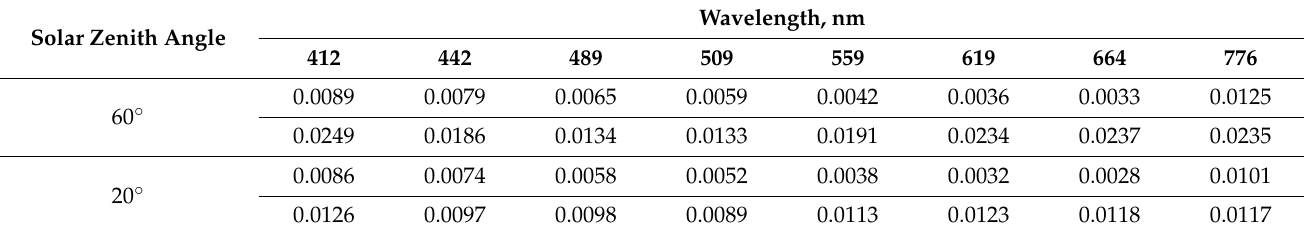
Table 6. RMSE of reflectance retrieval for dark (upper numbers) and bright (lower numbers) surfaces in the MZS HR channels. Solar Zenith Angle